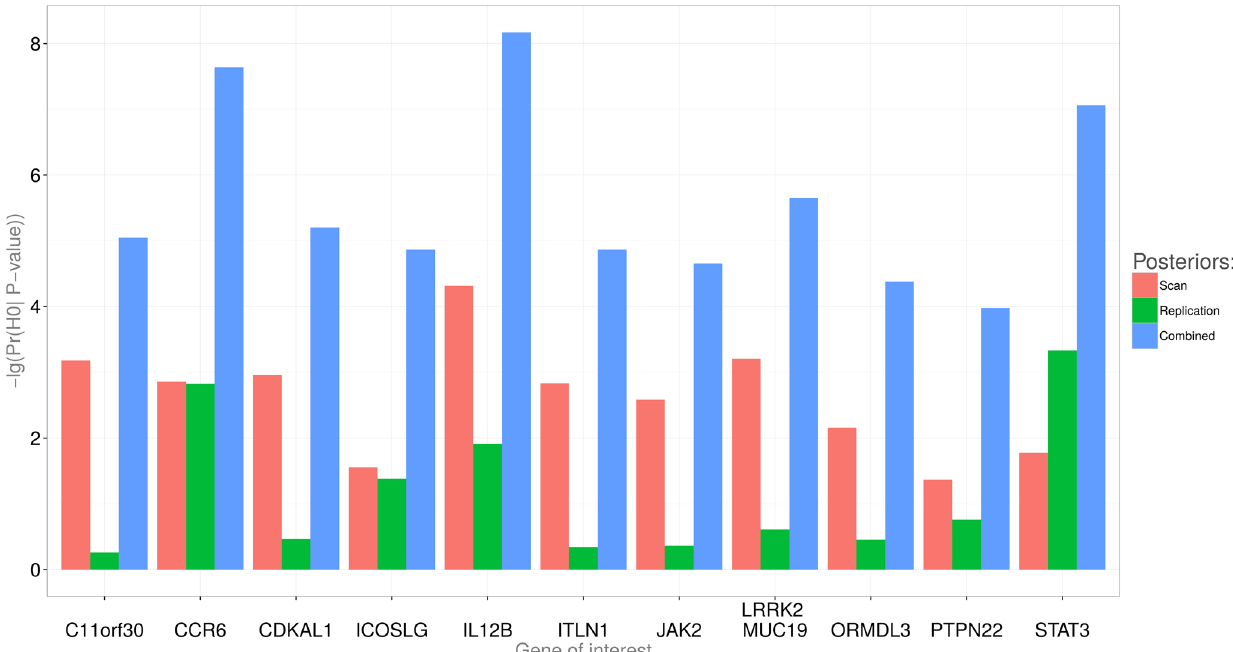
Fig 5. Probability that a finding is false (1-POFIG). The probability that the least significant newly identified loci reported in Barrett et al. is false. The prior probabilities are based on the estimates for the total number of susceptibility SNPs reported in Park et al. The shape parameter 0.634 was chosen to yield the median value of the noncentrality distribution to be twice as small as that of the exponential distribution (Shape = 1) for the same value of the scale.